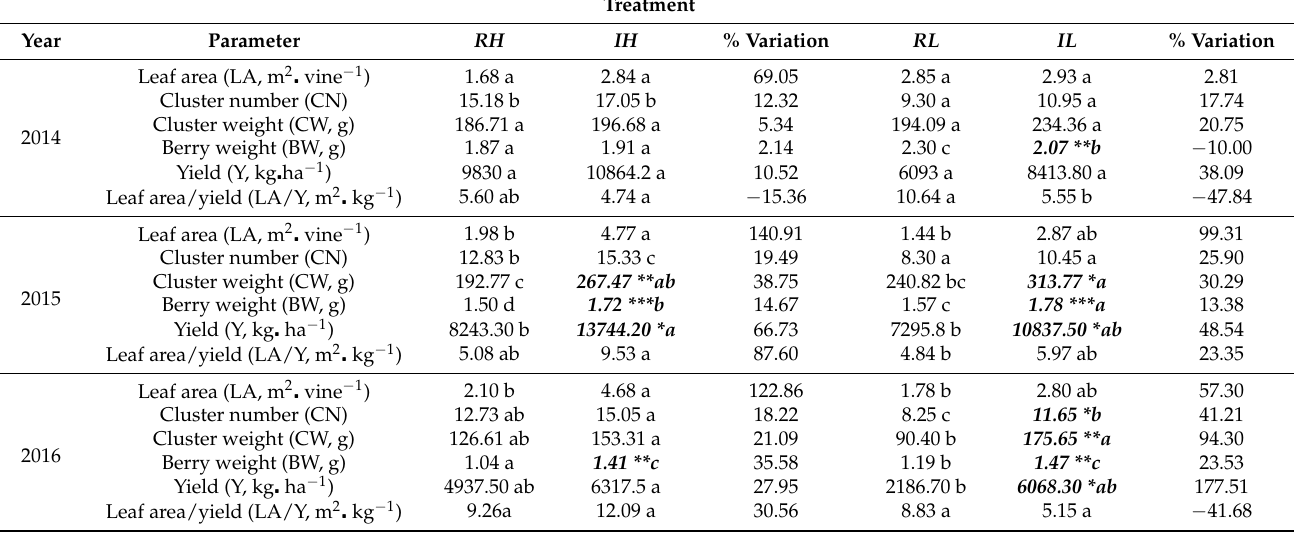
Table 3. Influence of irrigation on yield components and vegetative growth at harvest under two crop load levels during the 2014–2016 seasons. R : rainfed; I : unrestricted irrigation; H : high crop load; L : low crop load.